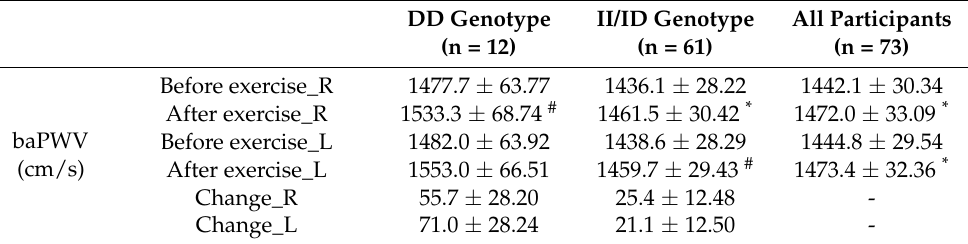
Table 4. Comparison of baPWV for different genotypes before and after exercise and the change of baPWV after the